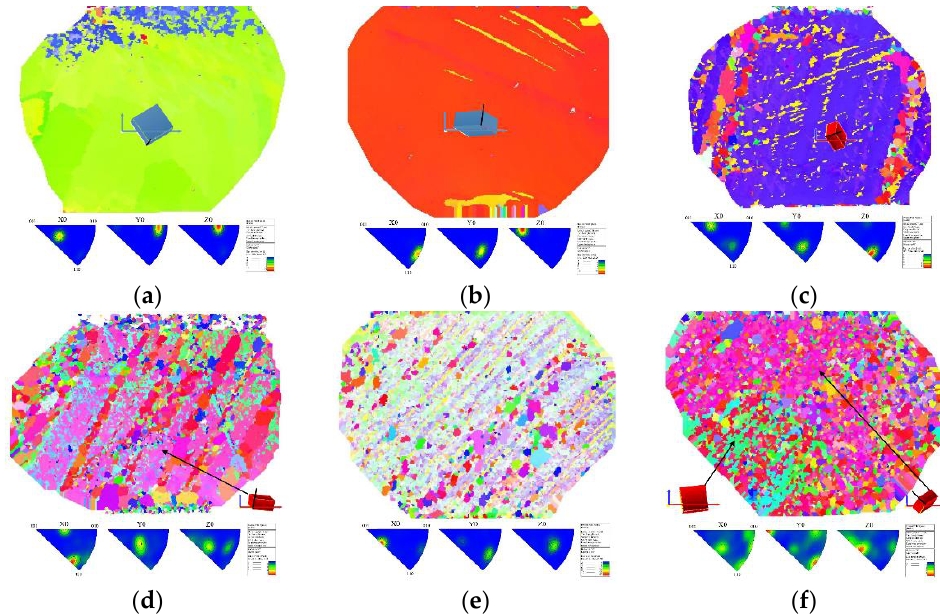
Figure 4. EBSD images with the inverse pole figures of three samples. ( a ) Sample 1#L, ( b ) Sample 1#R, ( c ) Sample 2#L, ( d ) Sample 2#R, ( e ) Sample 3#L, ( f ) Sample